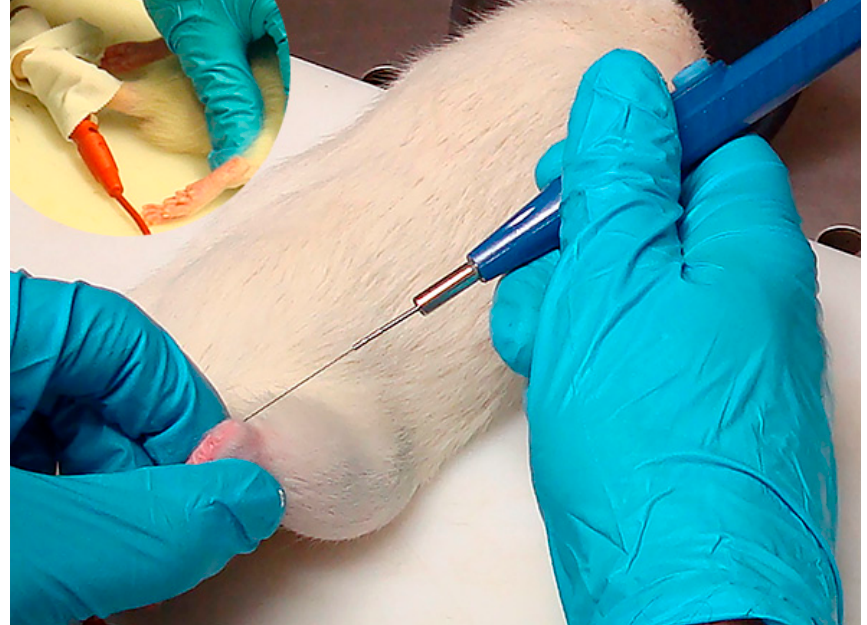
Figure 1. Application of Percutaneous Electrolysis (EPI© device) on the Achilles tendon of a rat. The positive electrode was placed on the tail of the rat with a cinch (figure on the left top